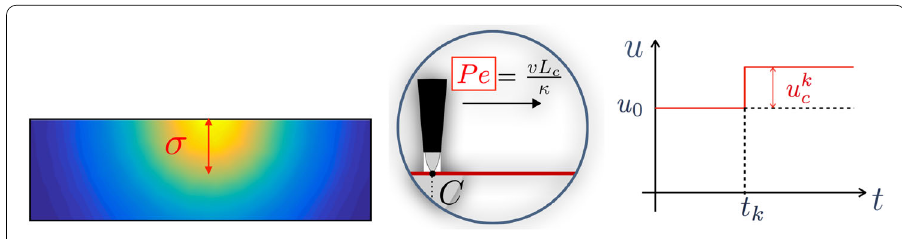
Fig. 3 Illustration of the two model parameters (left and center), and time evolution of the command (right)